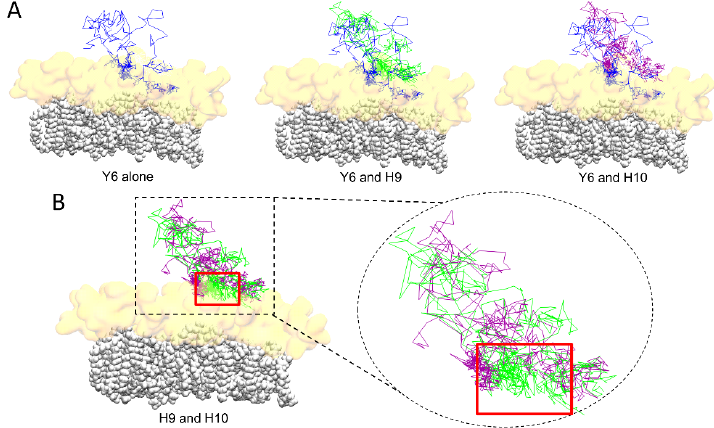
Figure 5. ( A ) Trail of aromatic residues of AmyP53 throughout the trajectory for Y6 alone (blue line, left), or compared to H9 (green line, middle), or compared to H10 (purple line, right). ( B ) Comparison of the trail of H9 (green line) and H10 (purple line). The ceramide chains of GM1 molecules are depicted as white spheres and the sugar moiety of GM1 is depicted as a transparent orange